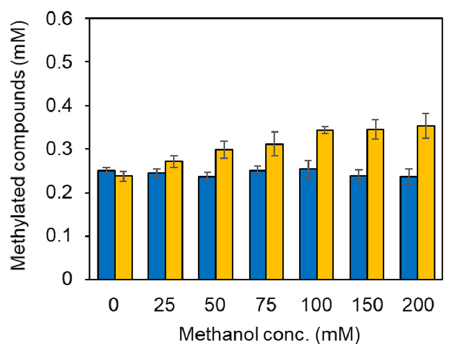
Figure 3. Methylation reactions with the MDH ‐ driven methanol metabolic pathway for 5 ‐ methyl ‐ THF formation. Methylation of esculetin was performed by adding various concentrations of methanol for 18 h using OMT/ Δ metJ cells (blue bars) and OMT ‐ MDH/ Δ metJ cells (orange bars). Data bars represent the mean ± standard deviations for three independent experiments.